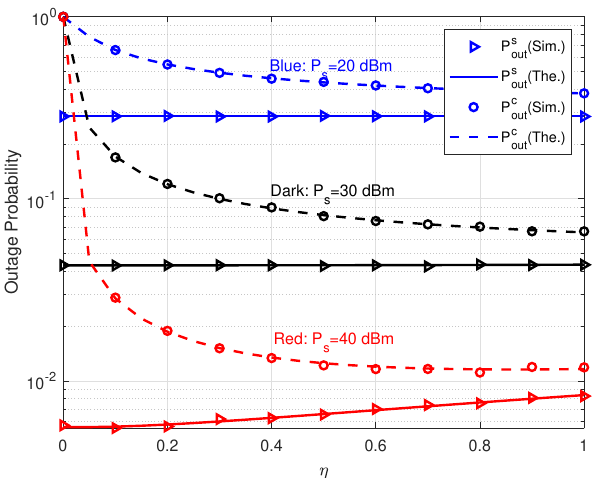
Figure 6. Outage probabilities versus η with different P s